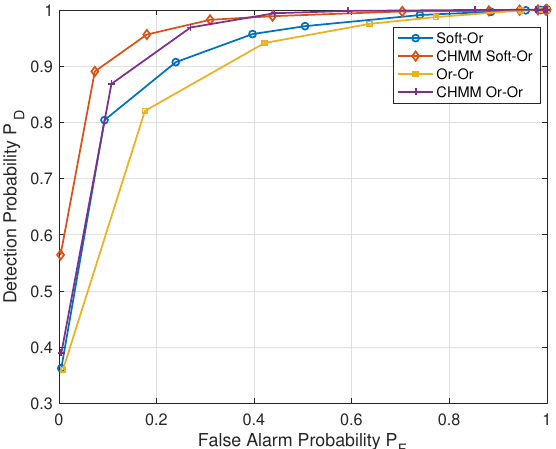
Figure 7. ROC of soft–or, or–or scheme and CHMM soft–or, or–or